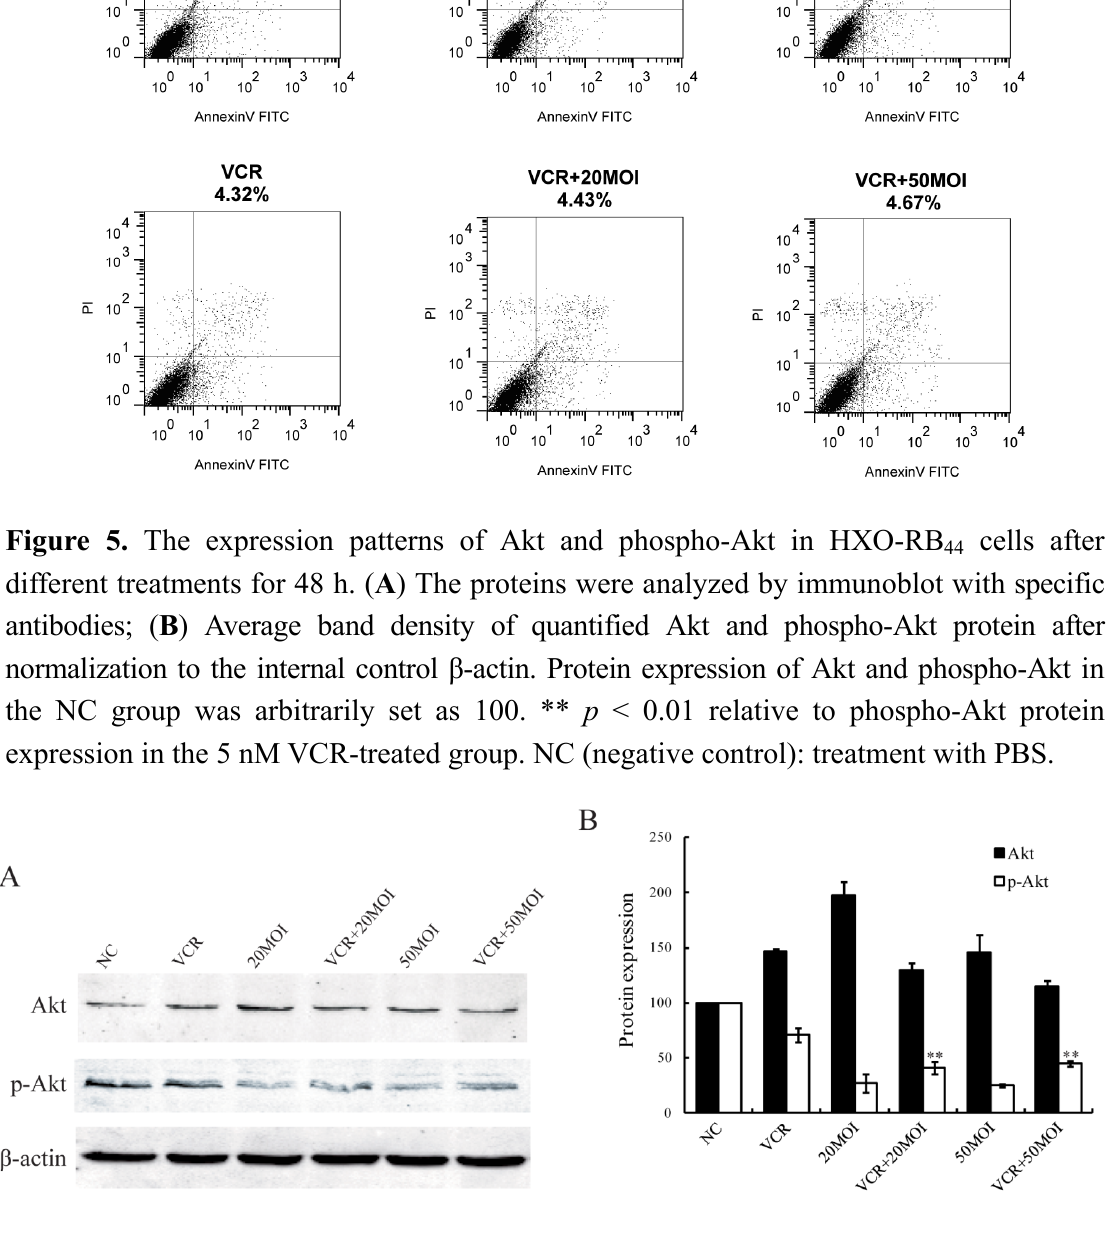
Figure 4. Detection of apoptosis in HXO-RB cells. Apoptosis was measured by flow 44 cytometry analysis 48 h after treatment with VCR (5 nM), SG600, and VCR plus SG600. Results are representative of three independent experiments. NC (negative control): treatment with PBS.